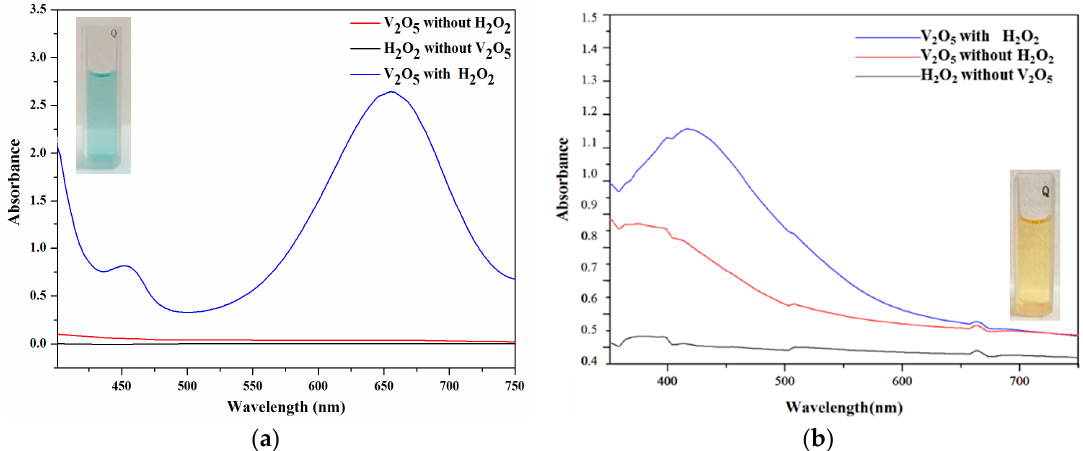
Figure 2. The catalytic effect of V 2 O 5 nanozymes with TMB ( a ) and OPD ( b ) as the substrate in the presence of H 2 O 2 .